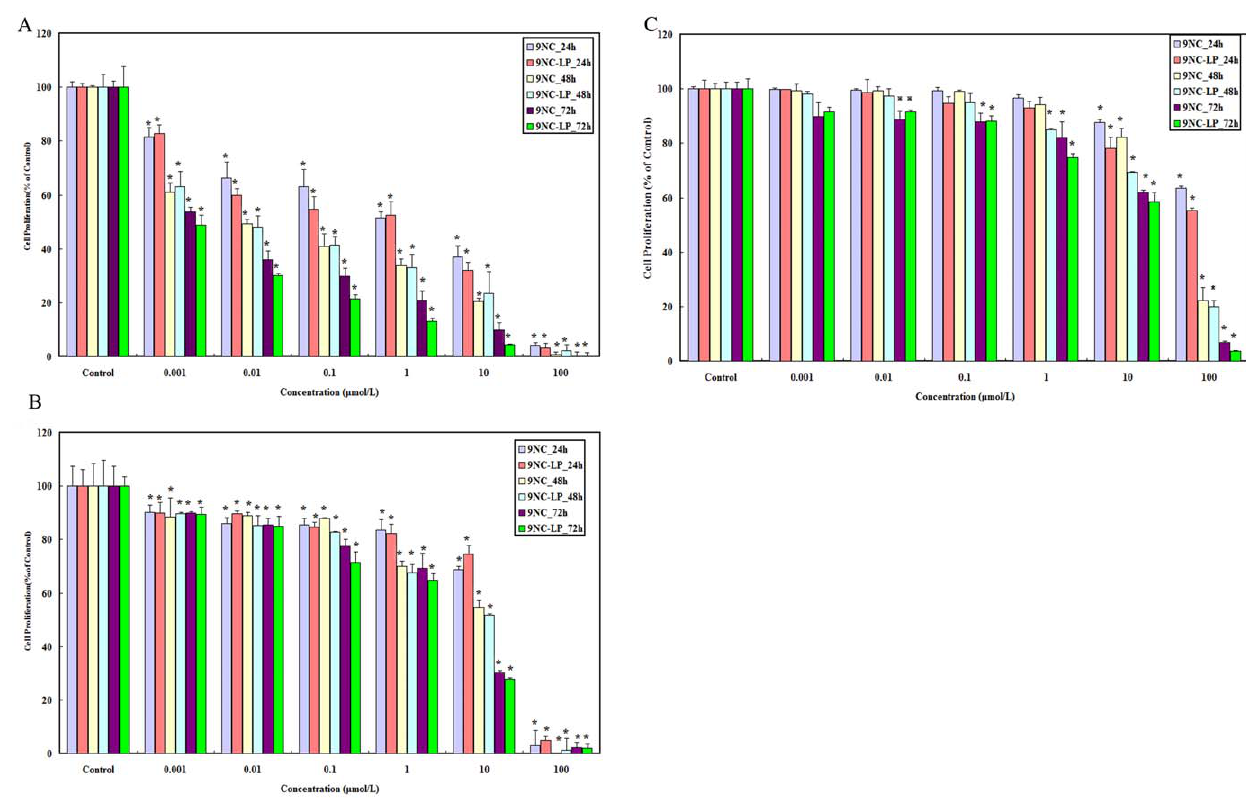
Figure 2. Cell proliferation inhibitory effects of 9NC and 9NC-LP on HepG2, L02 and Hep3B cells invitro . Cell proliferation of HepG2 (A) , L02 (B) and Hep3B (C) cells was measured after exposure to compounds for 24–72 h. All assays were done in triplicate. The proliferation index is in comparison with untreated cells (*P , 0.01, P , 0.05 vs. control) (There no significant differences between cells treated with 4 % DMSO, Liposomes (free) and untreated cells. Data not